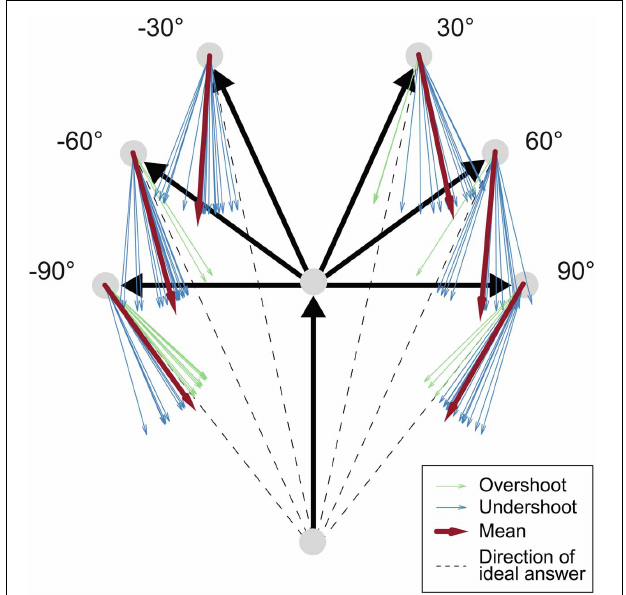
FIGURE 3 | Task schema and exemplary data. Black arrows: Traversed path. Dashed line: Ideal response. Blue arrows: Underestimated answers (exemplary answers from one single subject in the active condition). Green arrows: Overestimated answers. Red arrows: Mean answer angles. Comparing the difference between the red mean arrow and the dashed line in the 30 ◦ and 90 ◦ turning angle configurations shows that the amount of underestimation was less pronounced with increasing turning